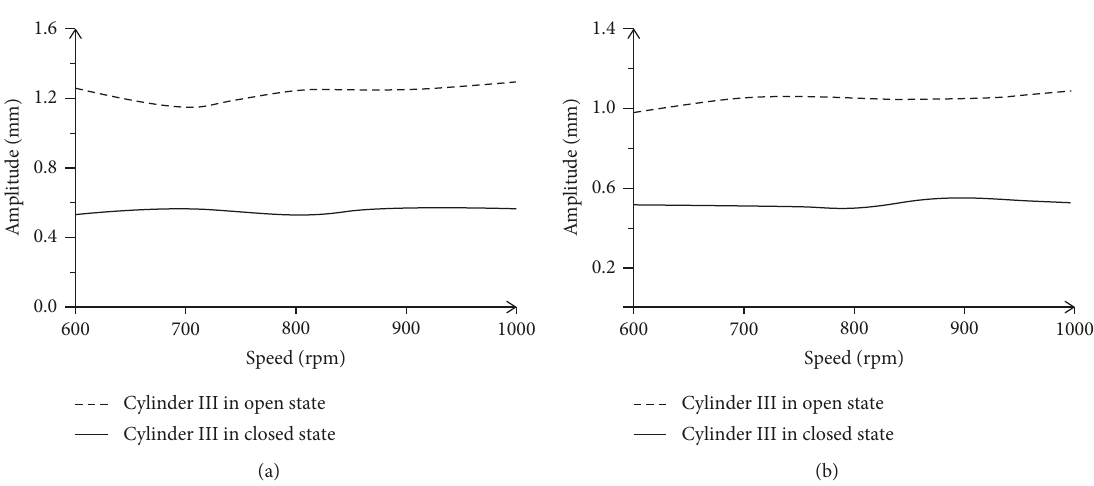
Figure 10: Axial amplitude of cylinder II under different conditions. (a) Horizontal amplitude. (b) Vertical amplitude.